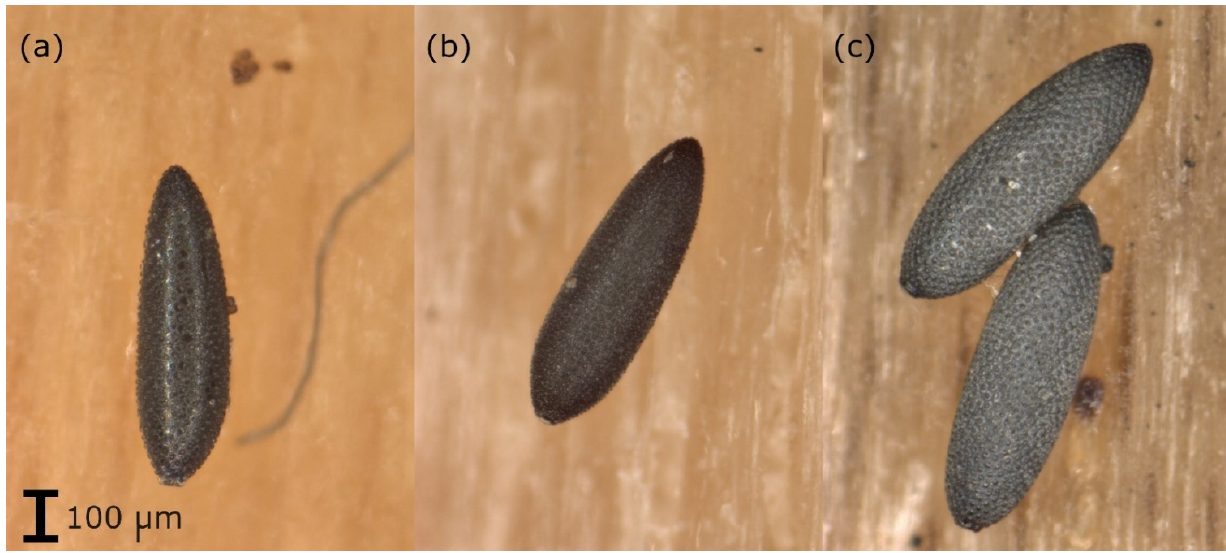
Figure 1. Eggs of ( a ) Ae. albopictus : eggs with a shiny black surface, with symmetrically arranged large but narrow tubers in the center of the chorionic cells, ( b ) Ae. japonicus : black eggs with a matte surface, with uneven and irregularly arranged tubers and ( c ) Ae. geniculatus : eggs with a black surface, with symmetrically arranged flat but broad tubers in the center of the chorionic cells, larger than Ae. albopictus or Ae. japonicus eggs.